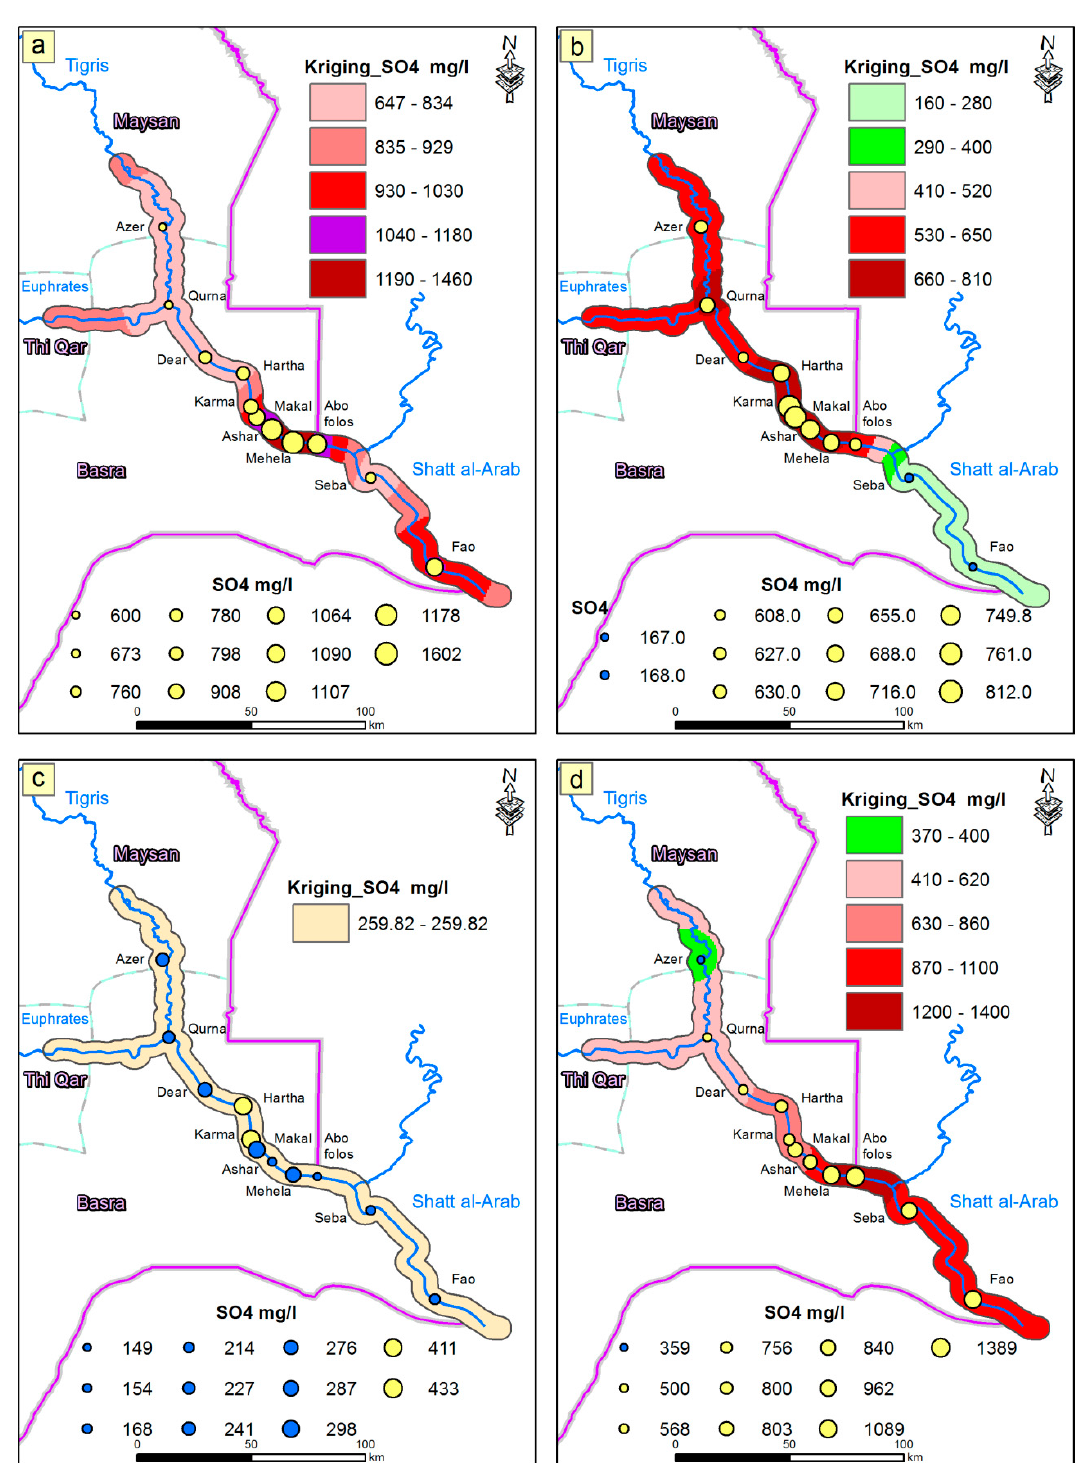
Figure A2. Spatial distribution of SO 42 − concentrations by kriging ( a ) winter 2018 ( b ) spring 2019 ( c ) summer 2019 ( d ) autumn 2019.